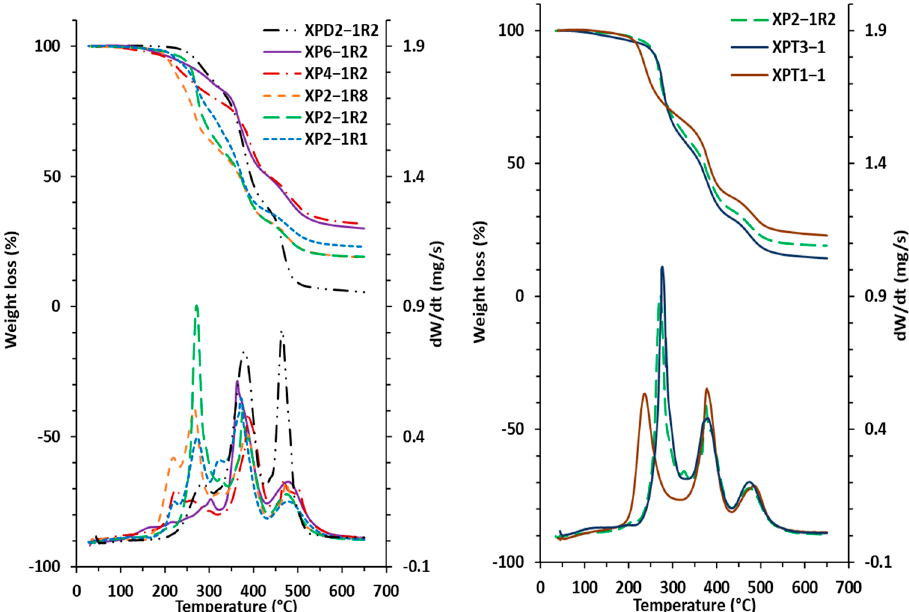
Figure 4. TGA (top) and DTG (bottom) spectra of the synthesized xerogels, describing the weight loss and derivate as a function of the temperature. Table 2. Main physico-chemical properties and parameters of the synthesized xerogels .